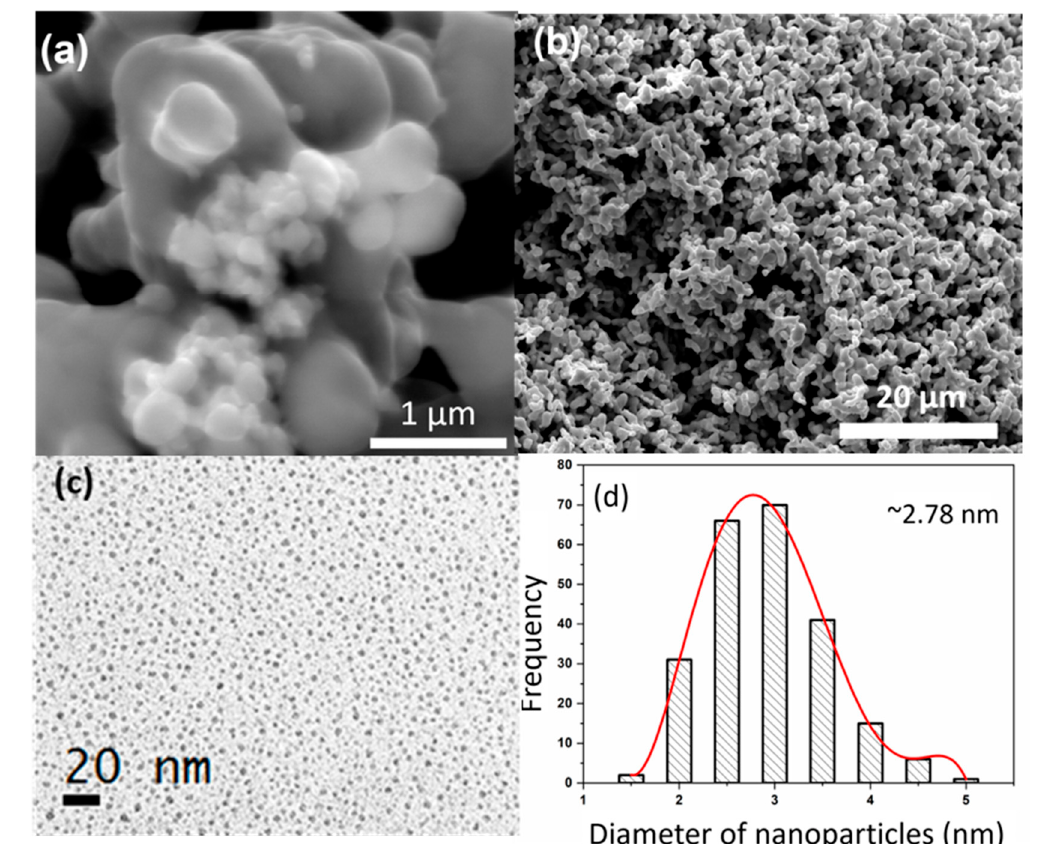
Figure 2. SEM images of Ag NP ( a , b ); TEM overview of Ag NP spread on carbon grid ( c ) and their size distribution histogram ( d ).